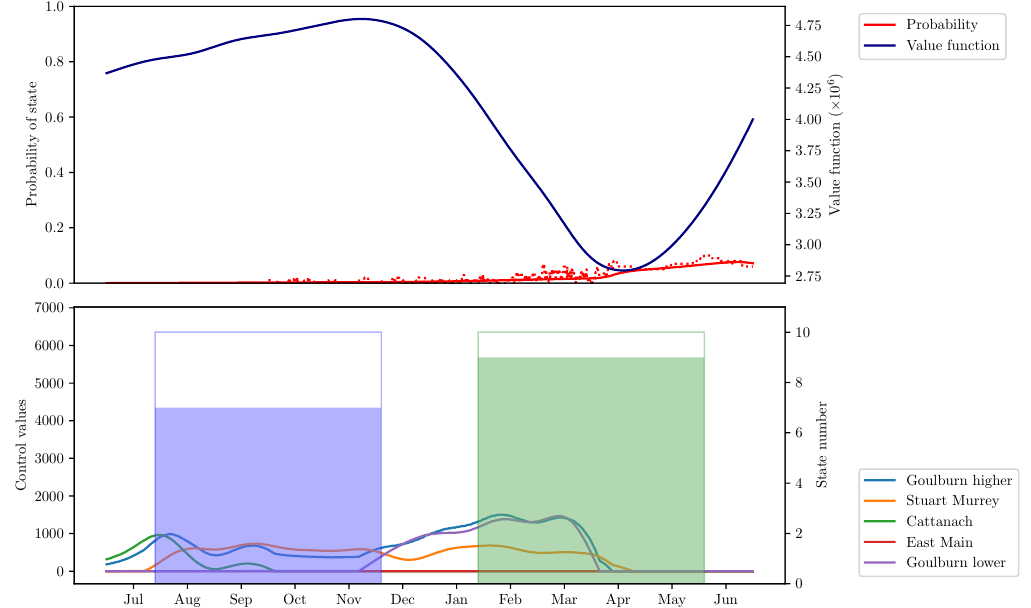
Figure 5. Probability of the state X 1 ( t ) = 7, X 2 ( t ) = 9, corresponding value function component ϕ 7,9 and optimal Markov control u ∗ 7,9